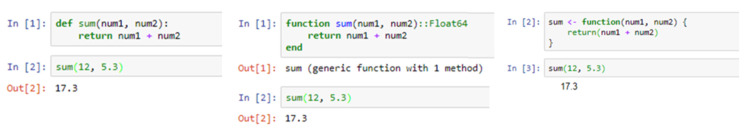
A simple function that returns the value of the sum of 2 numbers showing different kernels (programming languages) in the notebooks.(Left) Python, (middle) Julia, and (right) R.